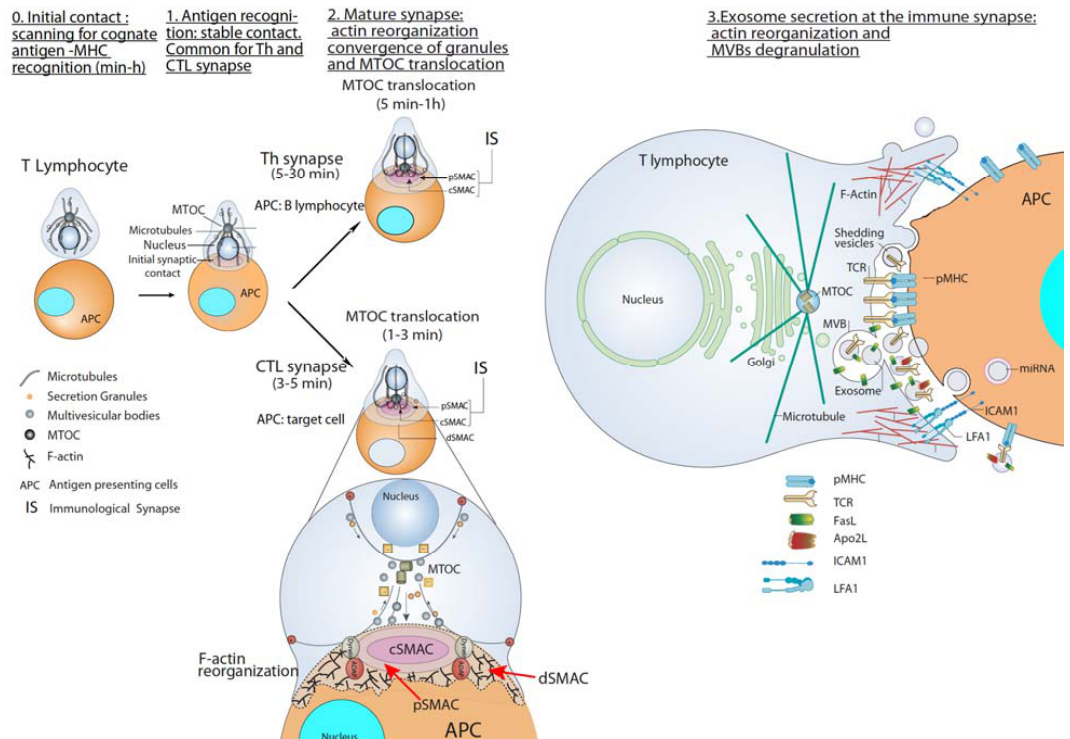
Figure 2. T lymphocyte—antigen ‐ presenting cells (APC) immune synapse (IS) and polarized secretion.